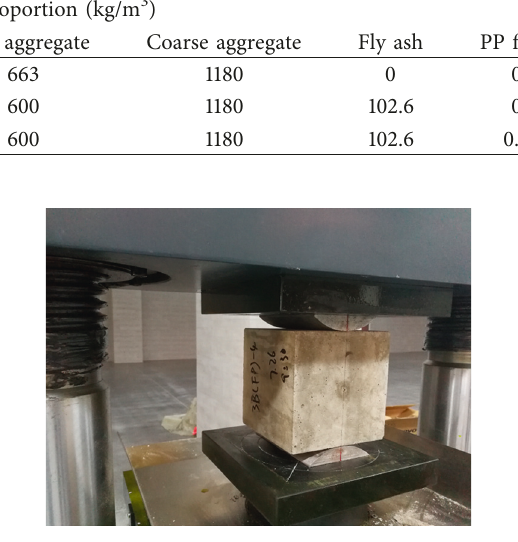
Figure 1: Splitting tensile strength experiment of